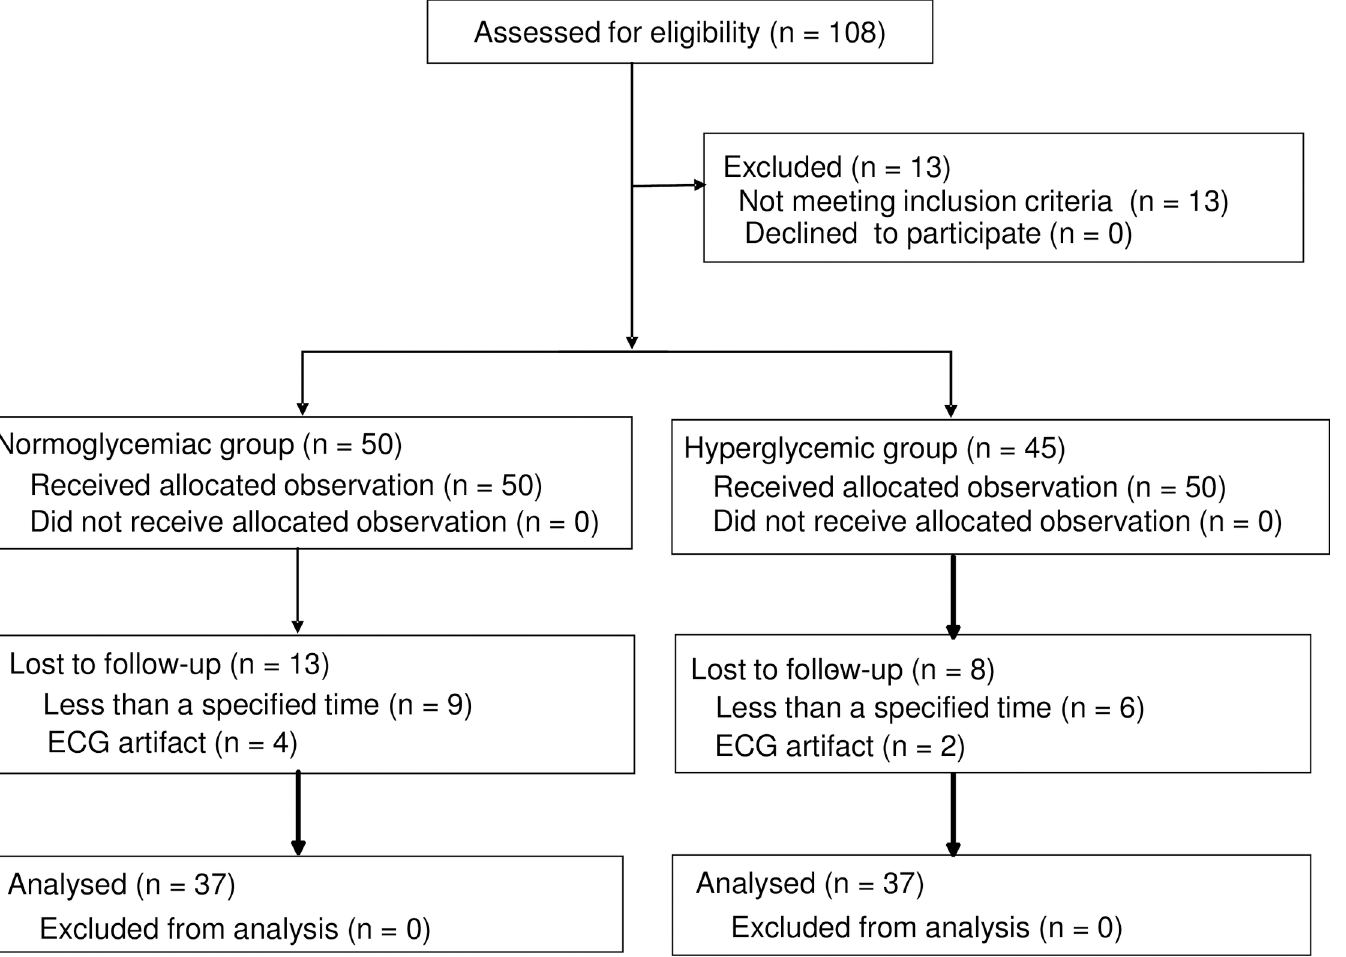
Fig 1. The structured patient flow chart for the experiment.